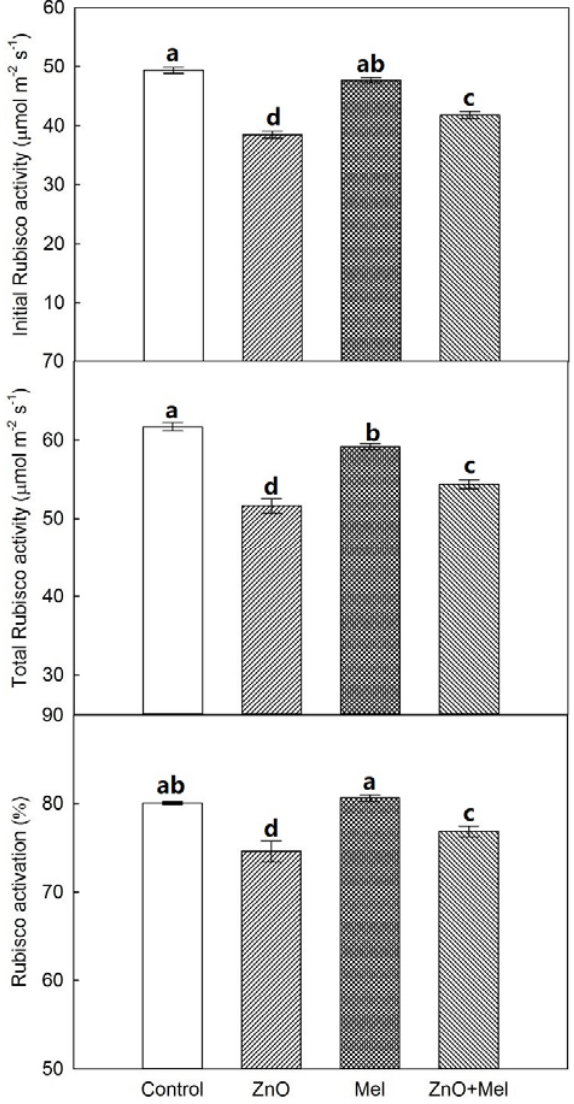
Figure 5. Initial and total Rubisco activities and activation in the last fully expanded leaf in wheat as affected by melatonin application and Zinc Oxide (ZnO) nanoparticles. Mel, melatonin. Data represent the mean ± SE of three replicates. Different letters indicate significant differences ( p < 0.05).